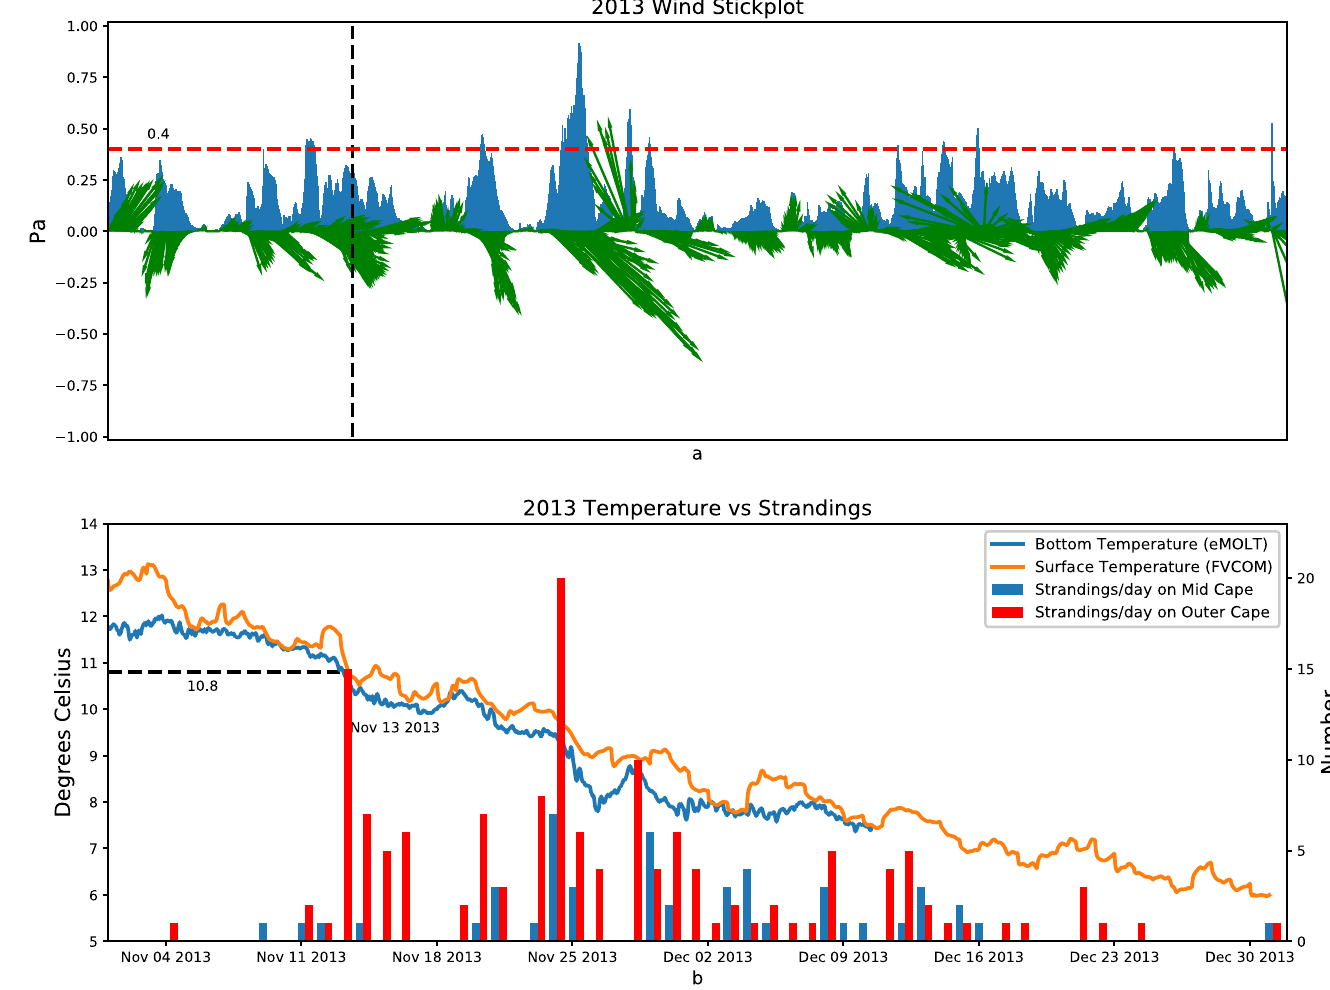
Fig 9. 2013: Top panel: Wind stress with direction shown in green vectors (north up) and magnitude in blue. Bottom panel: Mid Cape (blue bars) and Outer Cape (red bars) strandings, modeled surface temperature (orange line), and observed bottom temperature (blue line) in 2013.